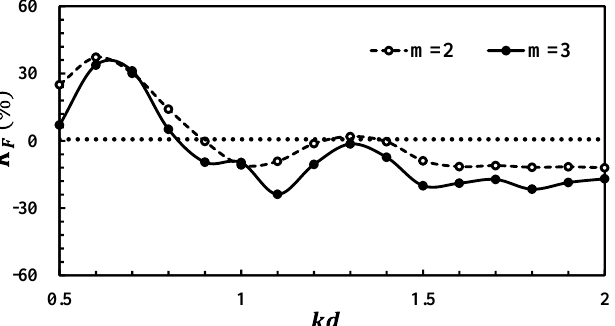
Figure 16. Variation of the wave force for the different porosities of the submerged breakwaters with kd = 0.6. ( a ) m = 2. ( b ) m = 3.